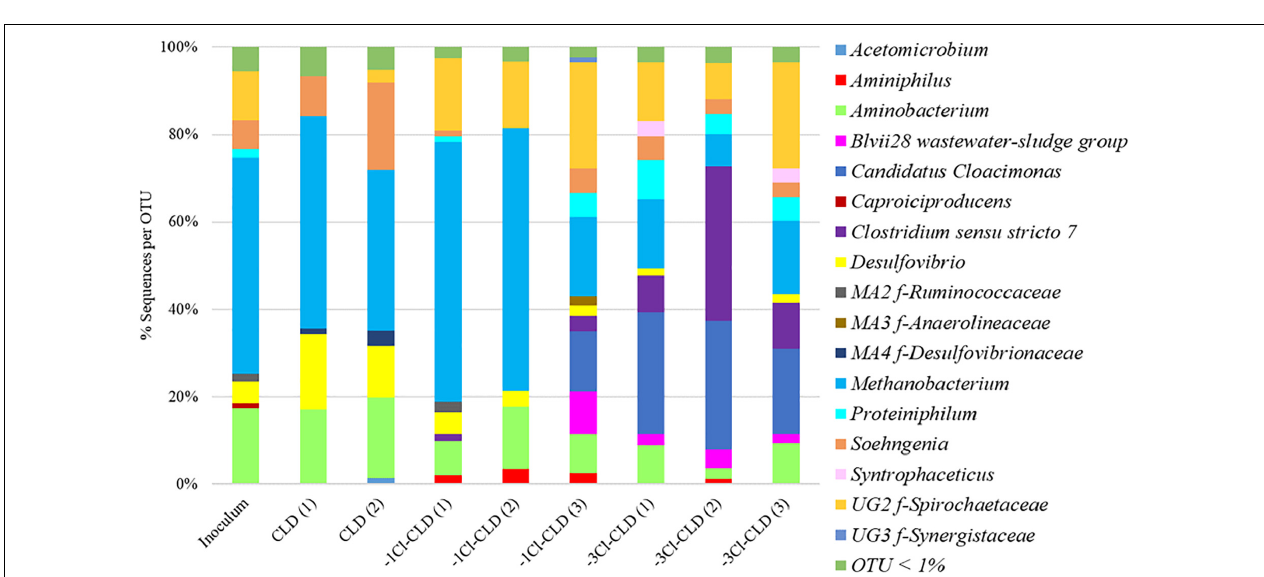
FIGURE 2 | General overview of the transformation products resulting from CLD, -1Cl-CLD, and -3Cl-CLD incubations. Entries 1–3 correspond to the kinetic experiment conditions after 8 months while entries 4 and 5 refer to the transfer experiment (after 90 days). The size of the circles gives a qualitative overview of the intensity of the GC-MS signals observed (mean of two injections). Analyses were conducted using GC-MS method 2. Complete data are found in Supplementary Table 1 .